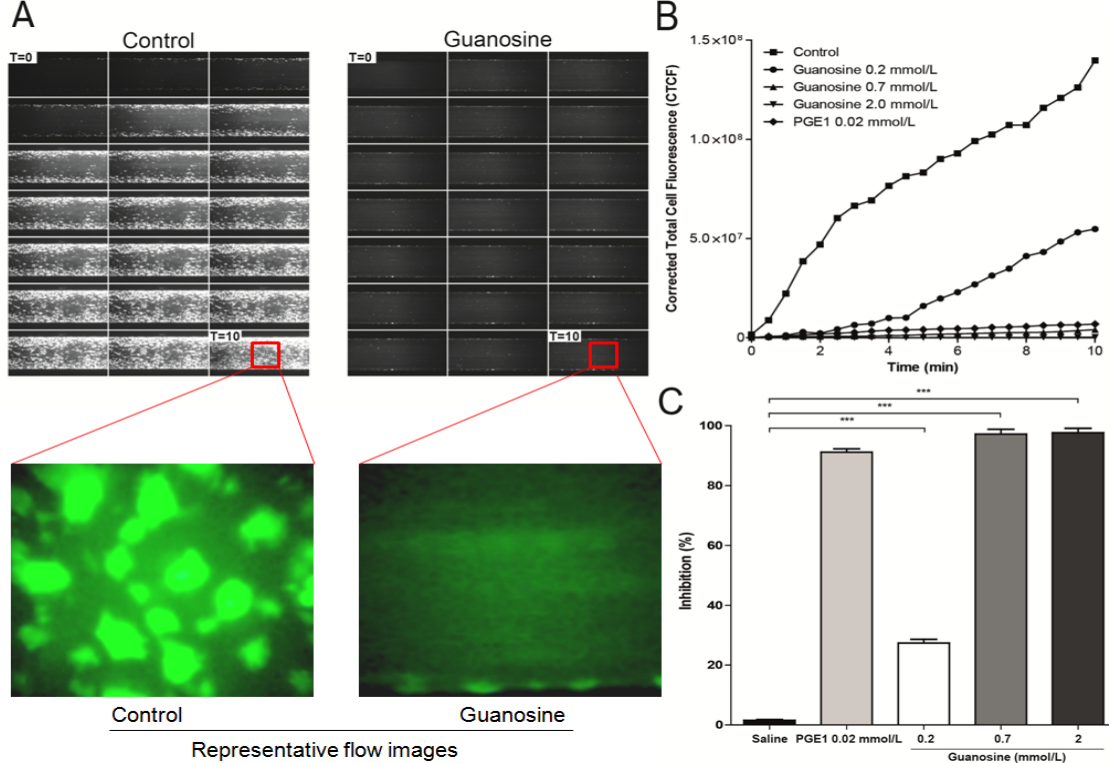
Figure 5. Effect of guanosine on collagen-induced platelet adhesion and aggregation under arterial flow conditions. Citrate-anticoagulated blood was pre-incubated with saline (control), PGE (0.02 mmol/L) or guanosine (0.2 to 2 mmol/L) for 1 hour and then was 1 perfused over plaque-coated surfaces for 10 min at room temperature at a shear rate of 1,000 s − 1 . ( A ) timelapse of 10 min at 1,000 s − 1 , at 30 s intervals, guanosine (2 mmol/L). ( B ) It shows the intensity (CTCF) over a time lapse. ( C ) bar diagram (values are mean ± SEM; n = 3). *** p <